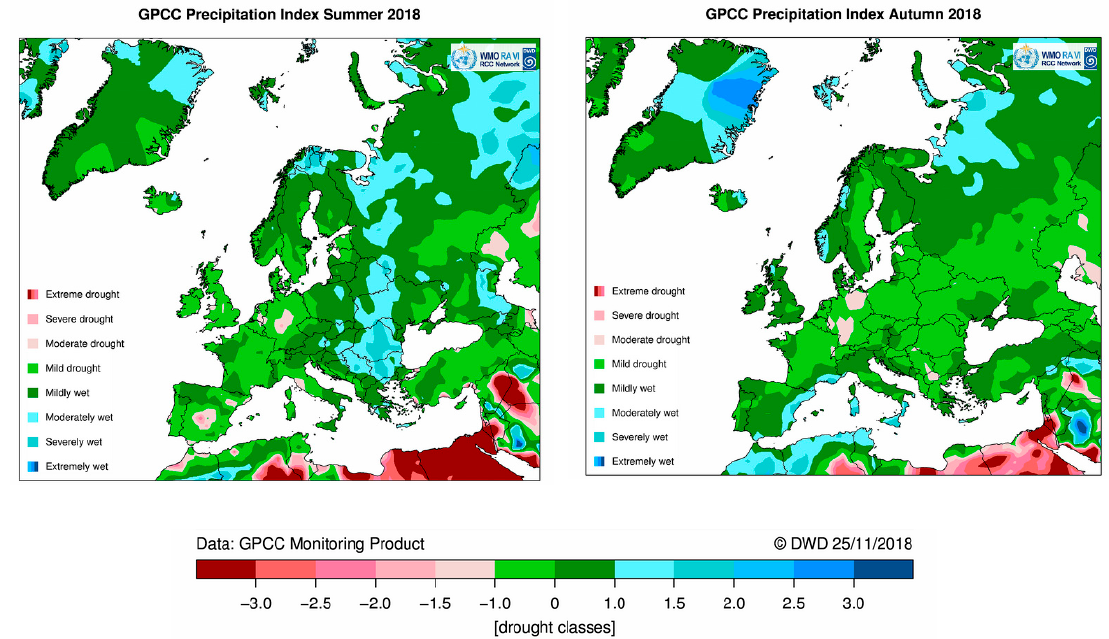
Figure 2. Distribution of the precipitation index (drought index) in summer and autumn in 2018 from the German weather service DWD [22], with permission. The precipitation index is calculated using weather, evaporation, and transpiration data, among others.